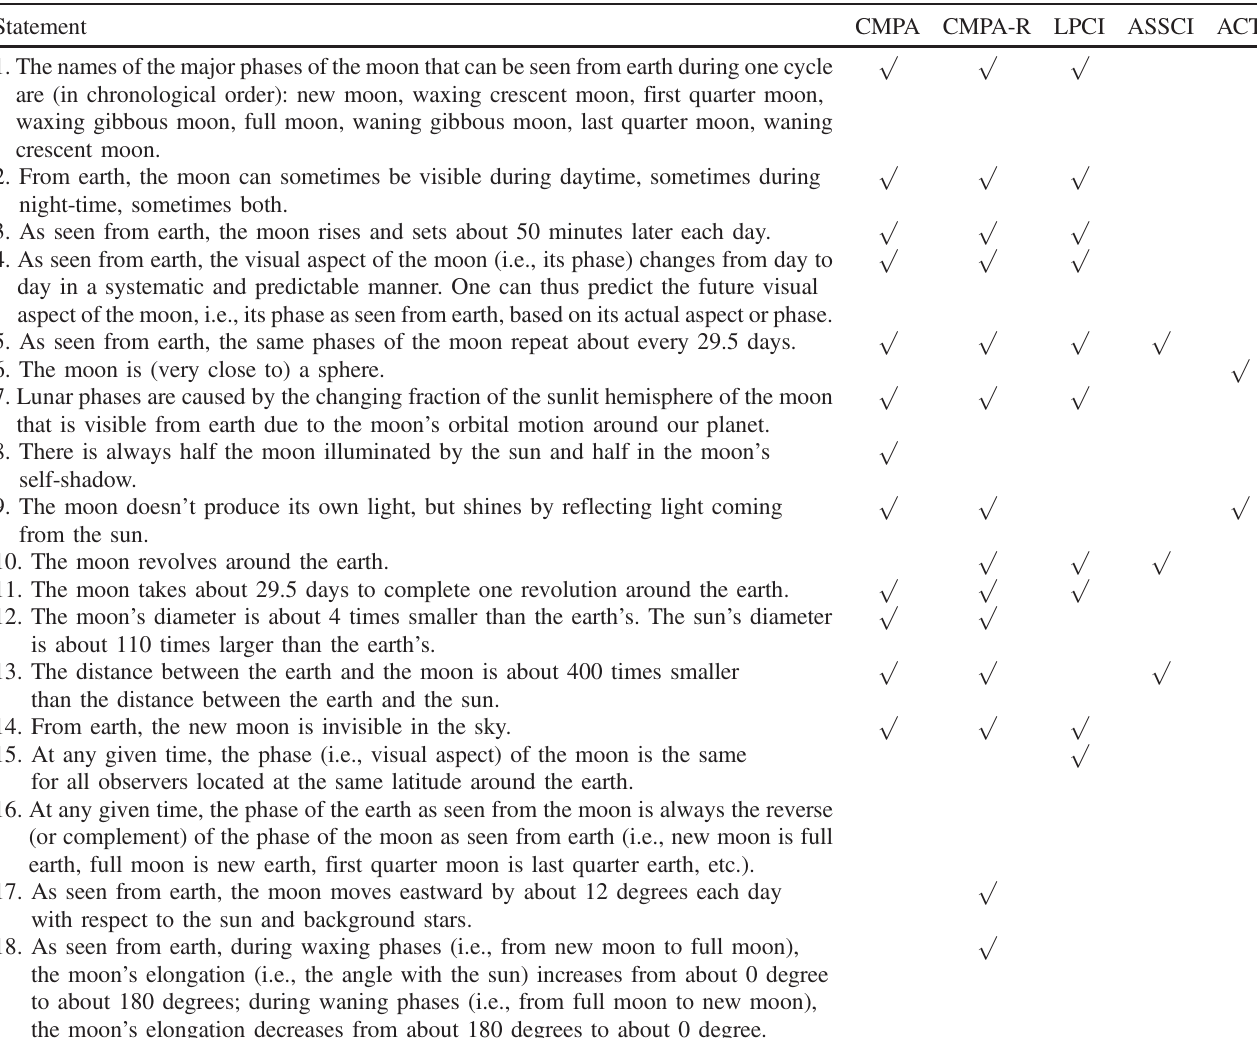
TABLE II. List of 18 statements considered “ Essential ” by seven professional astronomers to understand the mechanism of lunar phases and forming the MPCI-MS concept domain. Items targeting similar lunar phases concepts in the CMPA, CMPA-R, LPCI, ASSCI, and ACT are